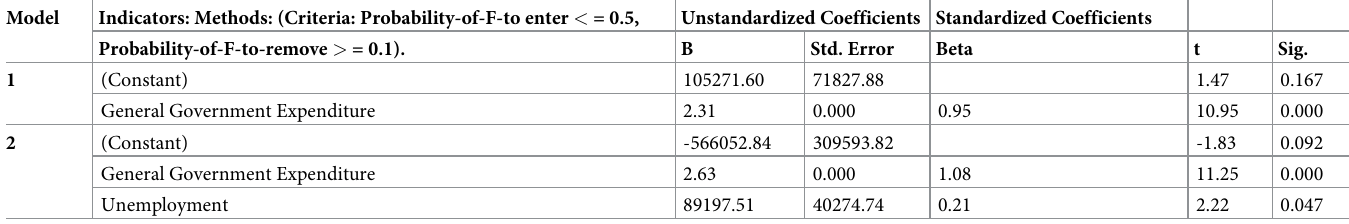
Table 4. Regression coefficients for the relationship between male enrollment, socio-economic factors (general government expenditure, unemployment rate, per capital income, GDP per capita (PPP constant 2011 international $), and GDP at market price) of Pakistan during 2001–02 to 2015–16. Model Indicators: Methods: (Criteria: Probability-of-F-to enter < =